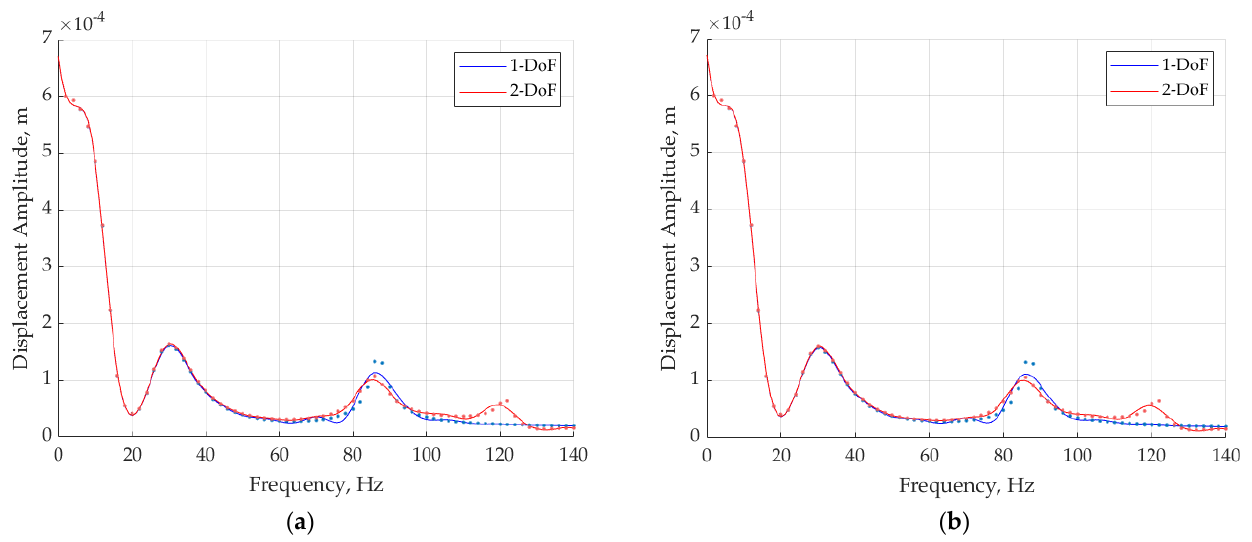
Figure 15. The amplitude as a function of the frequency of the 1-DoF and 2-DoF levitated magnet movement simulation for constant input current ( a ) 0.35 A and ( b ) 0.75 A.